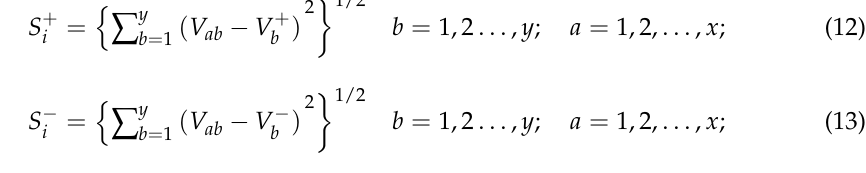
Table 15. Euclidian distance matrix. Without Breakdown With Breakdown